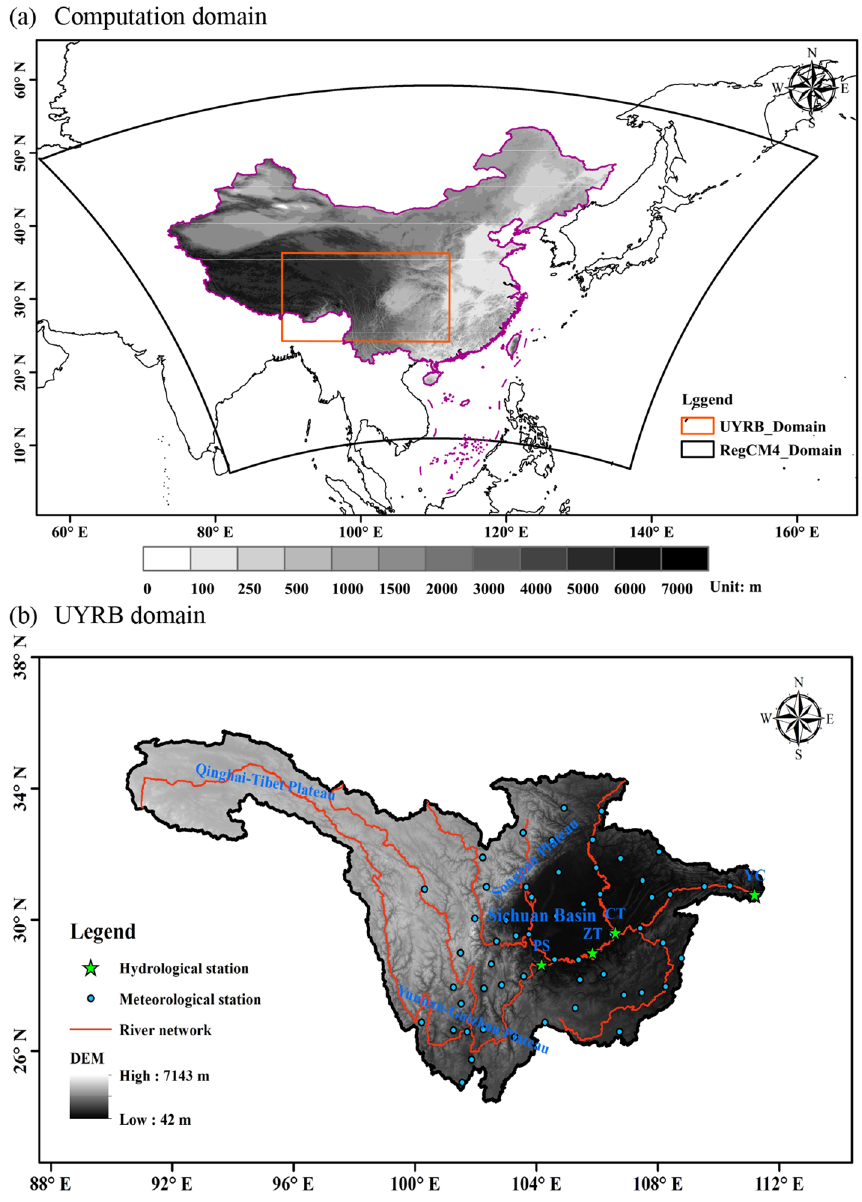
Figure 1. (a) Computation domain and topography (m) of RegCM4; ( b) the UYRB domain and topography (m). The figure was generated by Arcmap 10.6 (https:// www. esri.